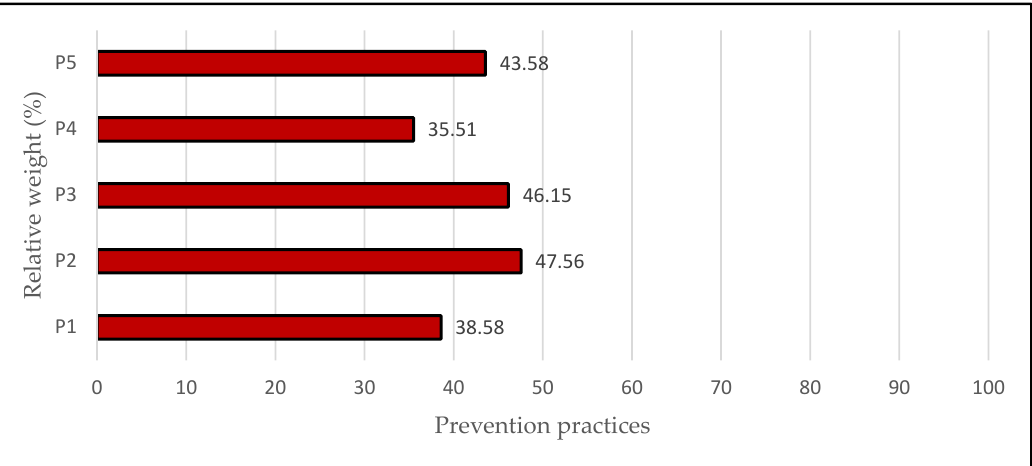
Figure 2. Farmers’ adoption of prevention practices for red palm weevil control. (P1 = checking trees at regular intervals to detect early infestation, P2 = removing offshoots as a protective measure, P3 = removing fonds by applying pruning in the winter, P4 = using pheromone traps to detect early infestation, P5 = treating wounds resulted from the removal of frond bases and offshoots using contact pesticides).